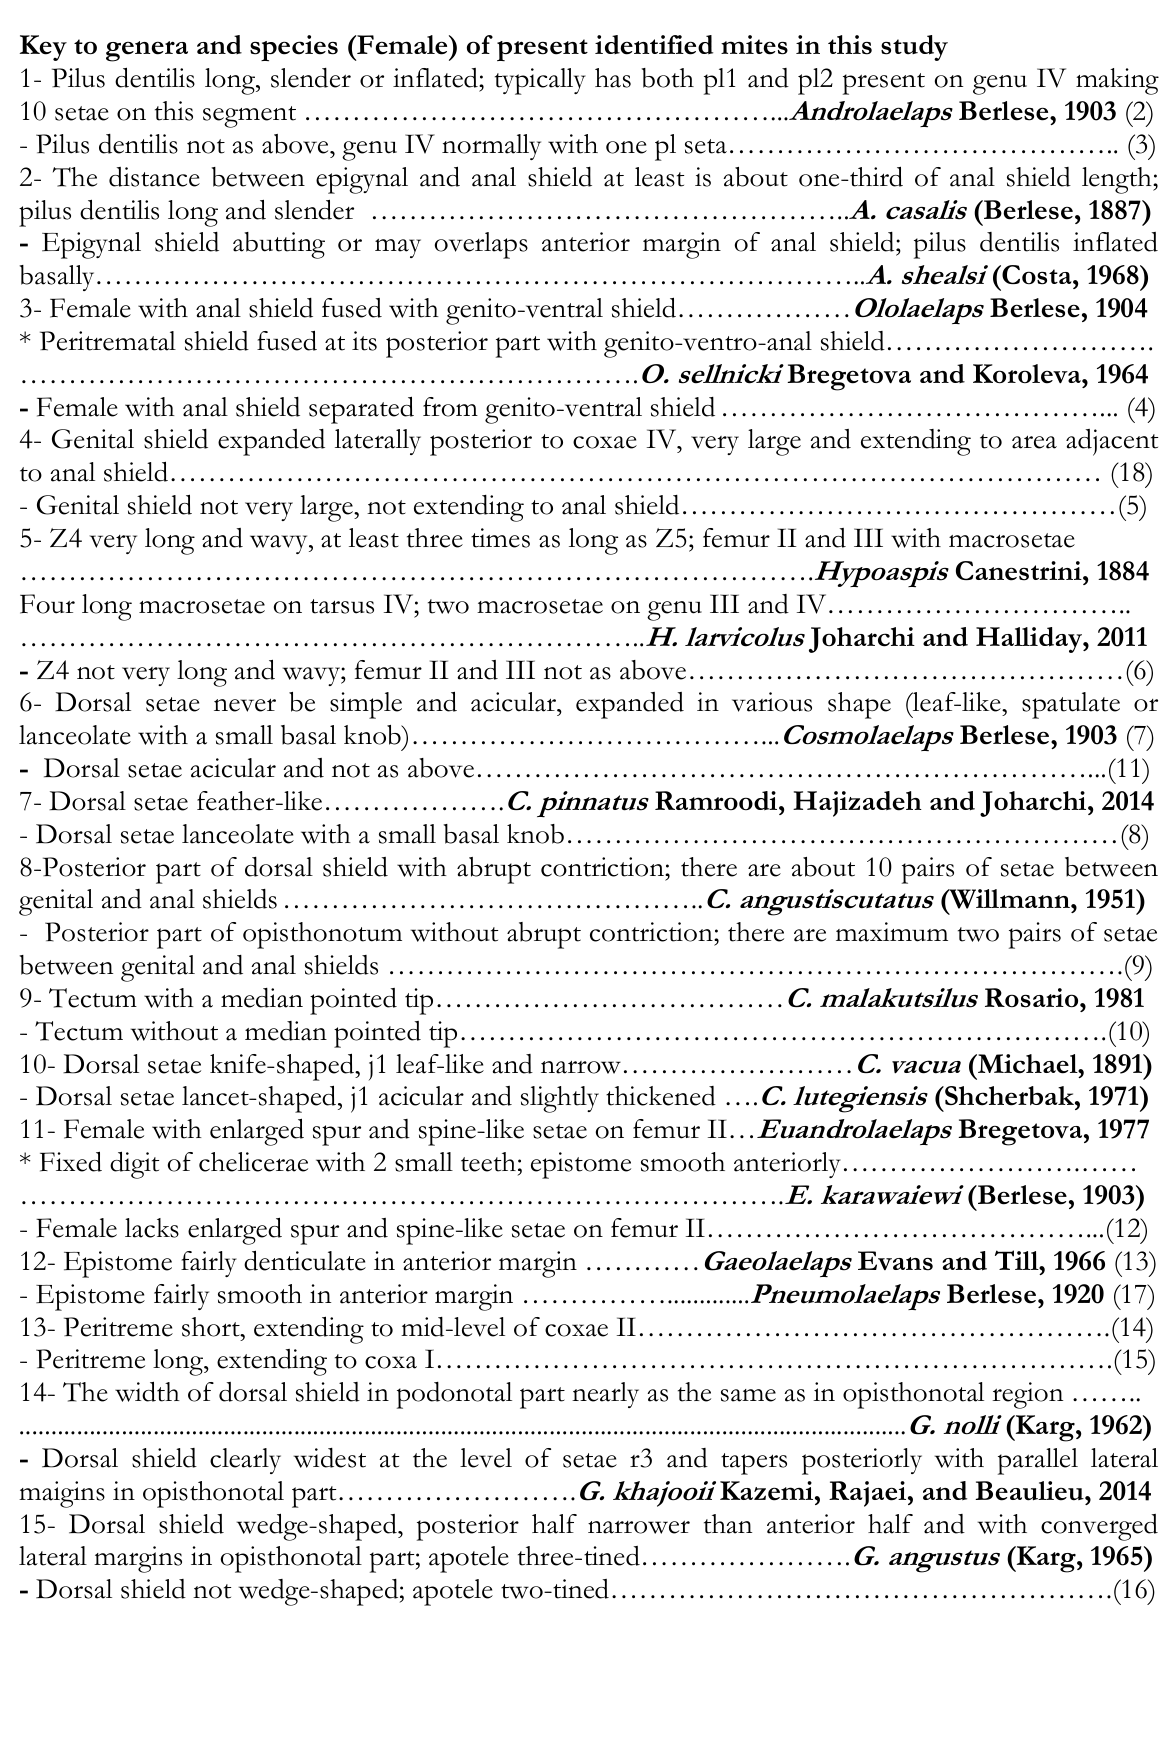
- Pilus dentilis not as above, genu IV normally with one pl seta………………………………….. (3) 2- The distance between epigynal and anal shield at least is about one-third of anal shield length; - Epigynal shield abutting or may overlaps anterior margin of anal shield; pilus dentilis inflated 3- Female with anal shield fused with genito-ventral shield……………… Ololaelaps Berlese, 1904 * Peritrematal shield fused at its posterior part with genito-ventro-anal shield………………………. 4- Genital shield expanded laterally posterior to coxae IV, very large and extending to area adjacent - Genital shield not very large, not extending to anal shield………………………………………(5) 5- Z4 very long and wavy, at least three times as long as Z5; femur II and III with macrosetae Four long macrosetae on tarsus IV; two macrosetae on genu III and IV………………………….. - Z4 not very long and wavy; femur II and III not as above………………………………………(6) 6- Dorsal setae never be simple and acicular, expanded in various shape (leaf-like, spatulate or lanceolate with a small basal knob)………………………………... Cosmolaelaps Berlese, 1903 (7) 7- Dorsal setae feather-like………………. C. pinnatus Ramroodi, Hajizadeh and Joharchi, 2014 8-Posterior part of dorsal shield with abrupt contriction; there are about 10 pairs of setae between genital and anal shields …………………………………….. C. angustiscutatus (Willmann, 1951) - Posterior part of opisthonotum without abrupt contriction; there are maximum two pairs of setae